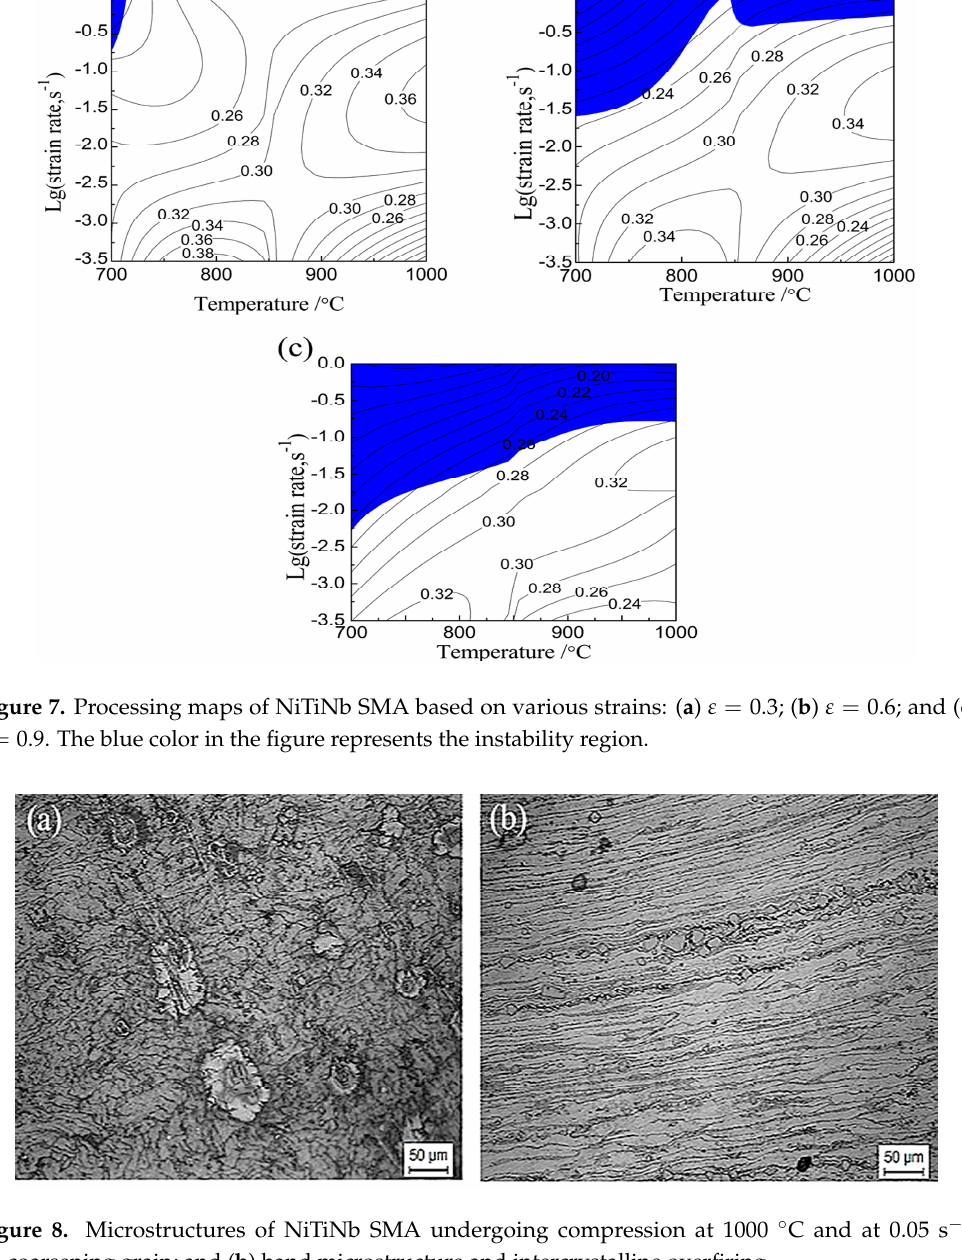
Figure 8. Microstructures of NiTiNb SMA undergoing compression at 1000 °C and at 0.05 s − 1 : ( a ) coarsening grain; and ( b ) band microstructure and intercrystalline overfiring.